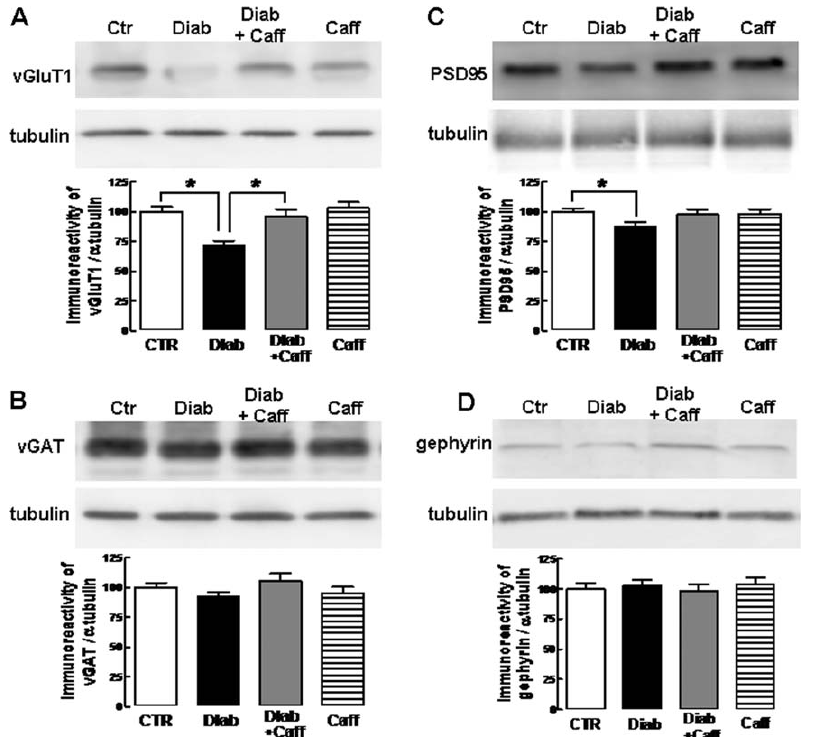
Figure 4. Diabetic mice display a selective loss of markers of glutamatergic rather that GABAergic synapses, which is prevented by caffeine consumption. Type 2 diabetic mice displayed a lower immunoreactivity for markers of glutamatergic (vesicular glutamate transporter type 1, vGluT1, A) rather that GABAergic nerve terminals (vesicular GABA transporter, vGAT, B), and lower immunoreactivity for post-synaptic markers of glutamatergic (pots-synaptic density 95 kDa protein, PSD95, C) rather than GABAergic synapses (gephyrin, D), and all these differences were blunted by caffeine consumption. Open bars represent control mice (CTR), black bars represent diabetic mice (Diab), grey bars represent diabetic mice consuming caffeine (Diab + Caff) and striped bars represent control mice consuming caffeine (Caff). Data are means 6 SEM of hippocampal membranes from 5 rats per group; * P , 0.05 between indicated bars.